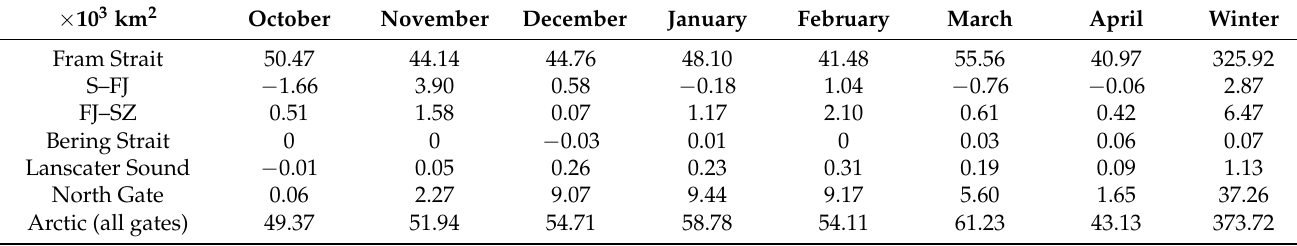
Table A2. Winter and monthly MYI